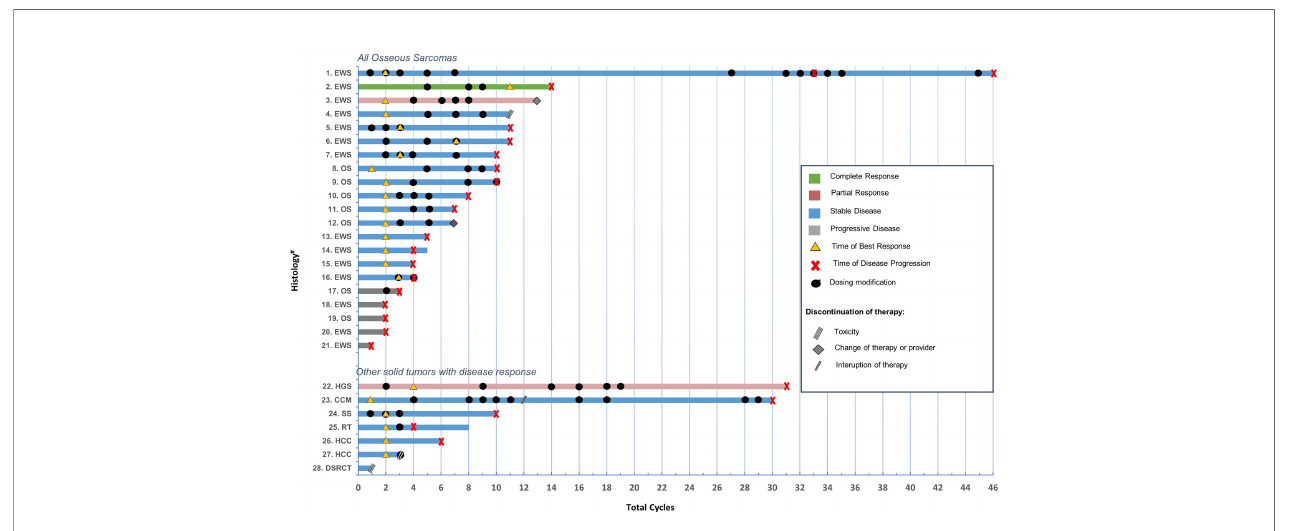
FIGURE 1 | Description of treatment duartion, clinical course, timing of dosing modi fi cations, best response, disease progression of all osseous sarcomas and additional solid tumors with response ( ≥ SD). *Details regarding dosing modi fi cations and unique variables is further described for each case in Supplementary Materials . #EWS, Ewing sarcoma; OS, osteosarcoma; HGS, high grade sarcoma; CCM, clear cell meningioma; SS, synovial sarcoma; RT, rhabdoid tumor; HCC, hepatocellular carcinoma; DSRCT, desmoplastic small round cell